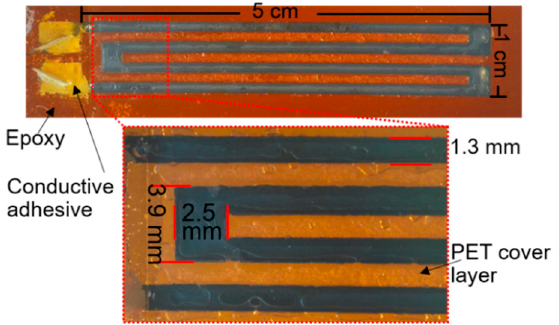
Figure 3. Photograph of printed strain sensor on a PI substrate (the inset shows the resulting uniform ink pattern and device dimensions) .